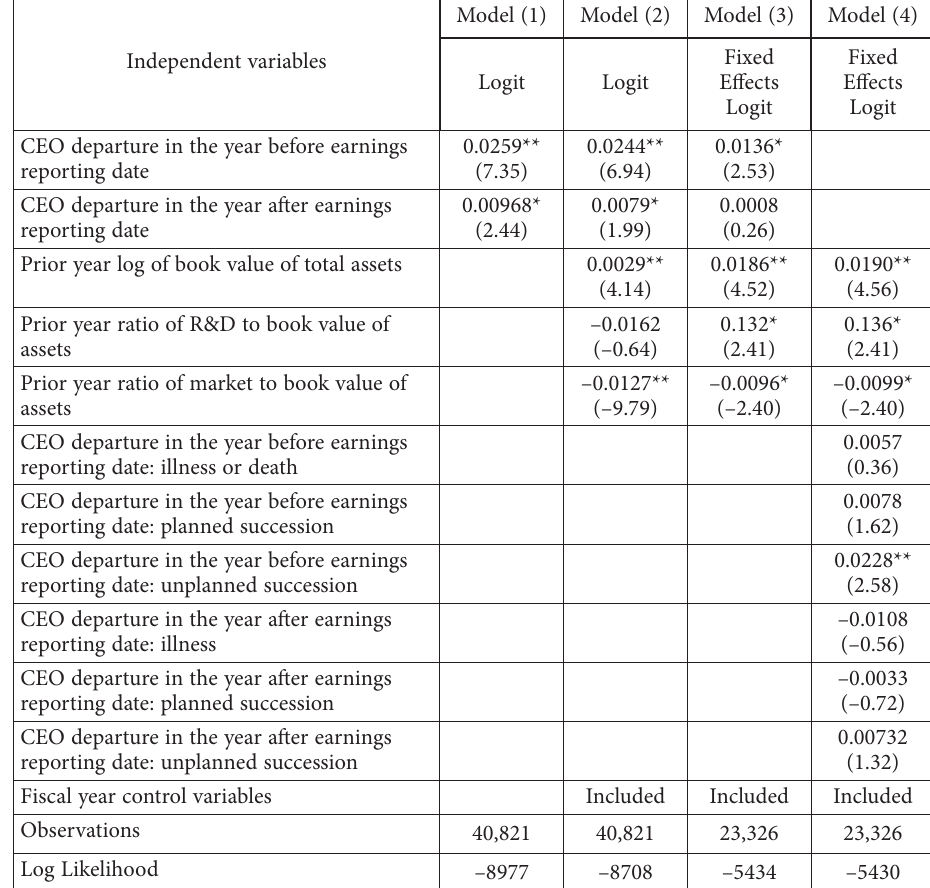
Table 5. New discontinued operation reporting surrounding departures of